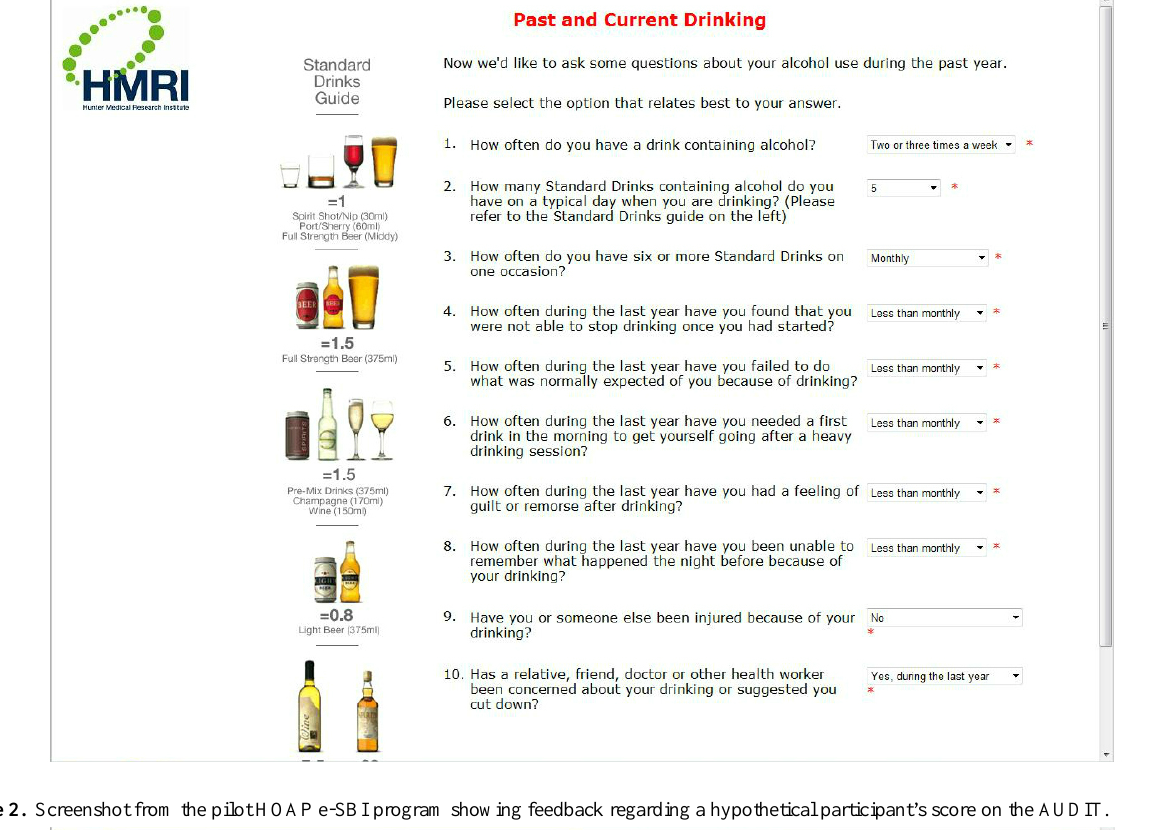
Figure 2. Screenshot from the pilot HOAP e-SBI program showing feedback regarding a hypothetical participant’s score on the